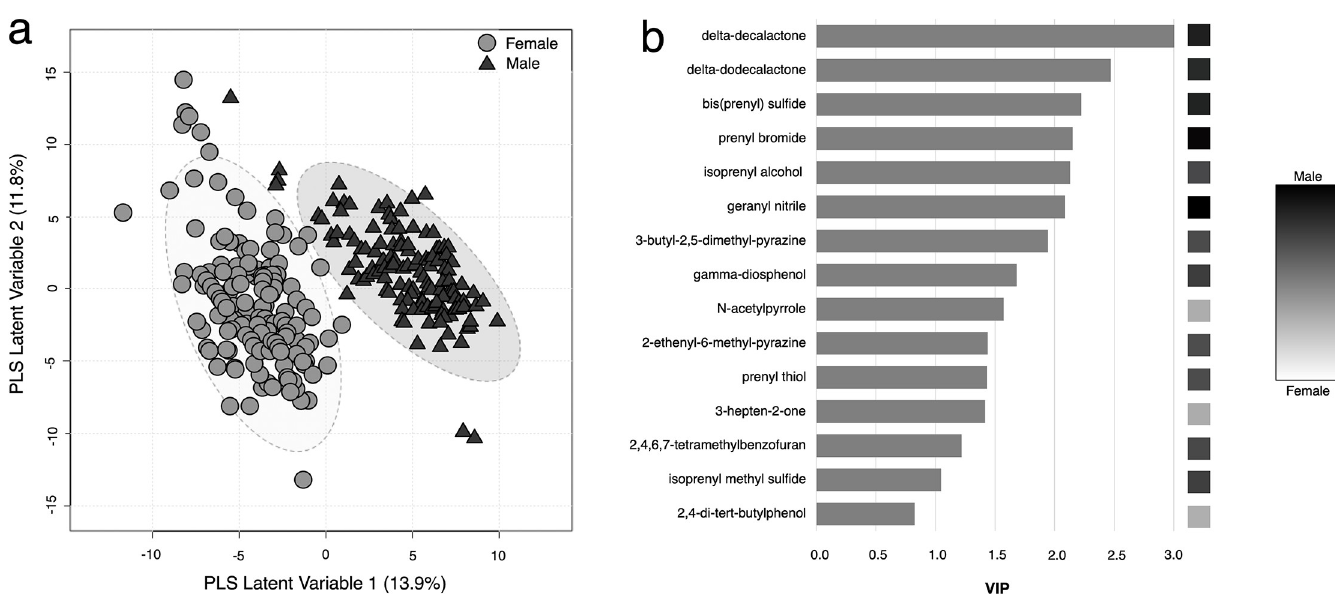
Fig 1. Classification of male and female urine samples based on abundance of 76 VOC. (a) Scores on first 2 latent variables from partial least squares-discriminant analysis shown for female samples (n = 161) in gray circles and male samples (n = 141) in black triangles. Variance explained by each latent variable is shown in parentheses. (b) Variable influence on projection (VIP) scores on partial least squares latent variable 1 shown for 15 VOCs with statistically significant differential expression. Boxes on right indicate the log 2 fold change in abundance of each VOC in male samples (n = 141) compared to female samples (n = 161).